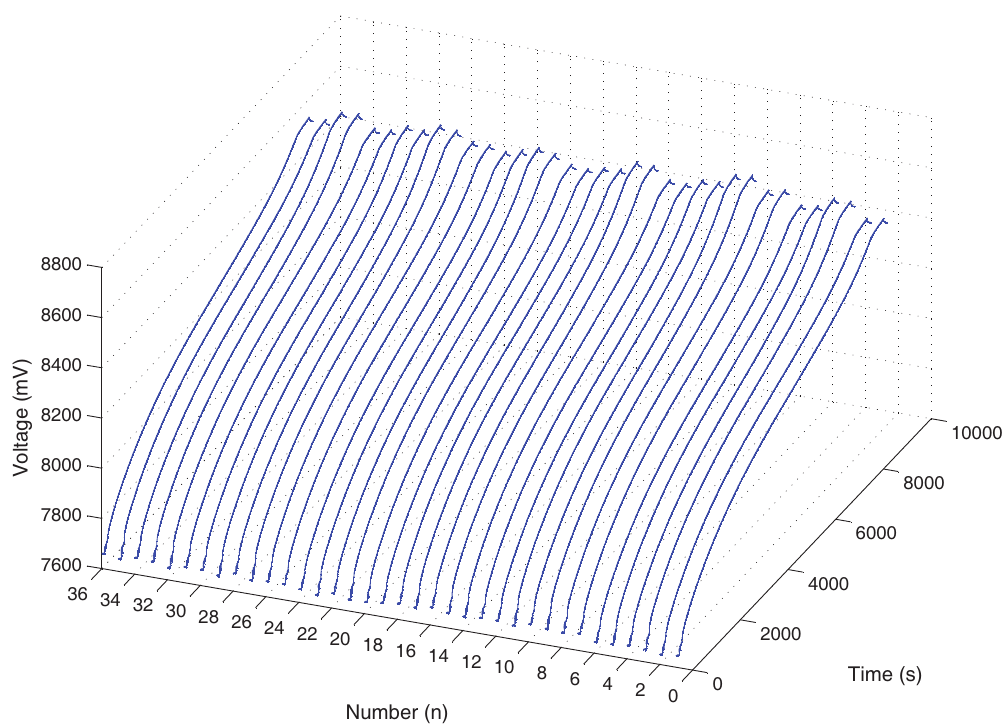
Figure 15. The voltage characteristic of monomer using proposed method of two years later.